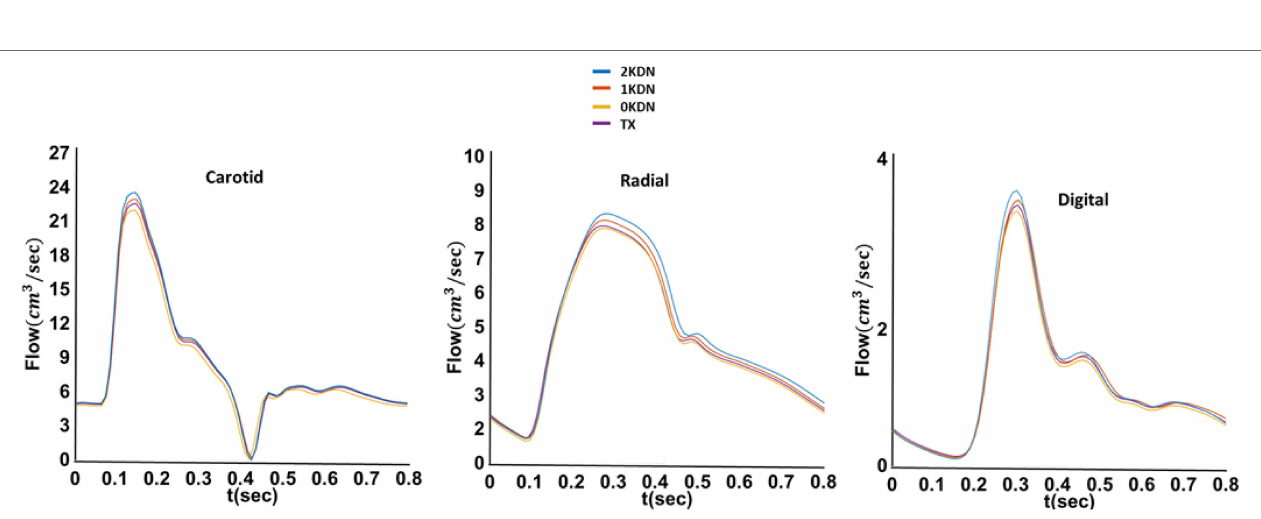
FIGURE 5 | Variations of the aortic flow waveforms in the four simulated configurations at four different locations in the aorta (default distensibility and in silico ).